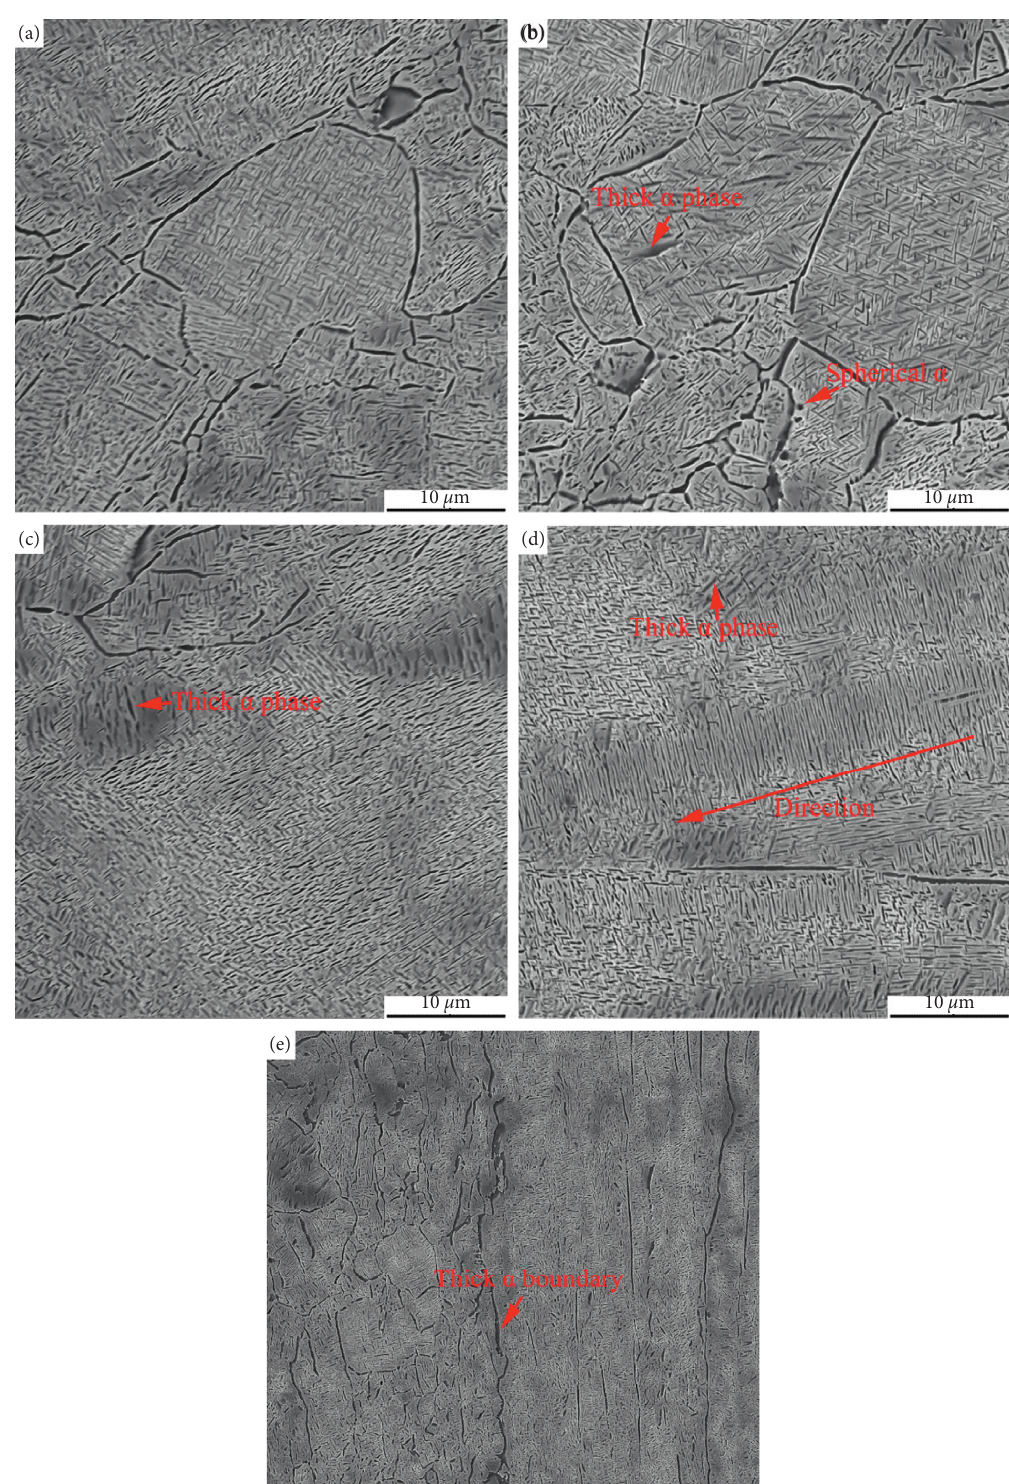
Figure 3: SEM of as-received materials: (a) and (b) in recrystallized parts; (c) and (d) in nonrecrystallized parts; (e) the SEM at longitudinal